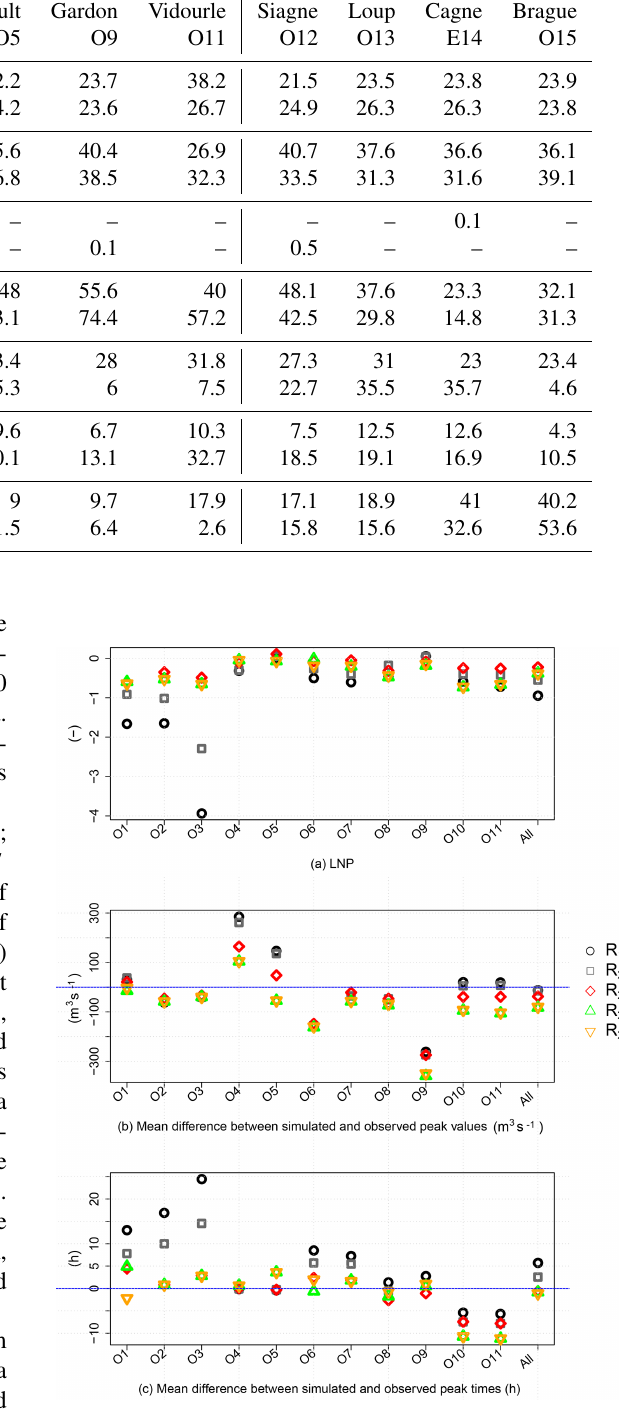
Figure 4. Scores for each watershed in zone A and all the outlets, for the R 1 T 1 C 1 –R 2 T 2 C 3